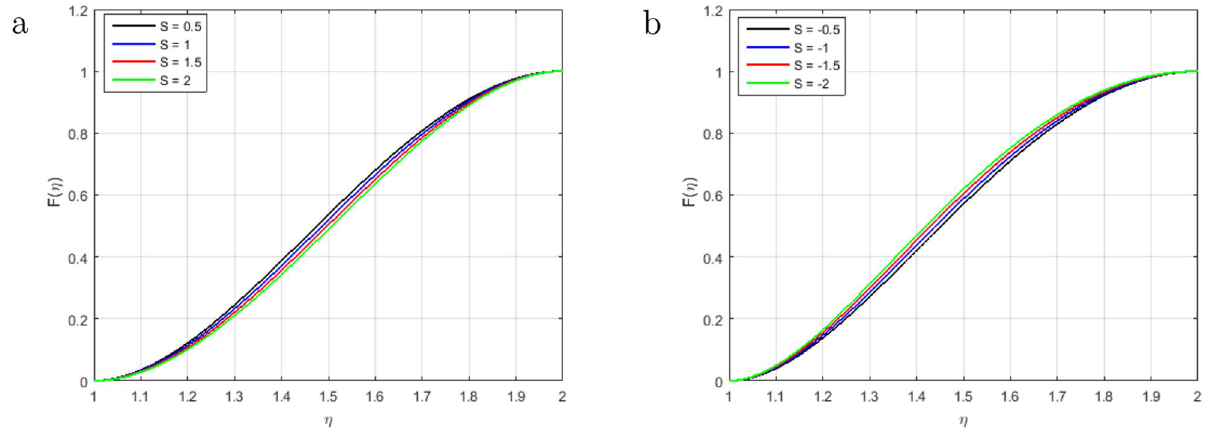
Figure 2. Influence of F (η) for S > 0 , S < 0 and fixed values of Re m = 2.5, M = 0.5, Pr = 3.2, Hs = 0.2, C 1 = 0.4, Sc = 0.4, Sr = 0.5